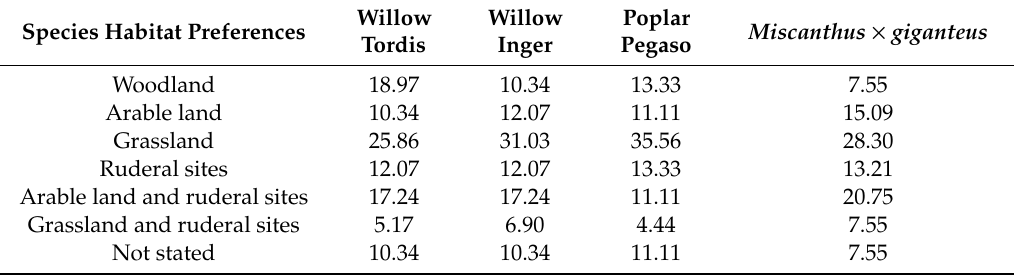
Table 1. Species representation based on species habitat preferences [%].